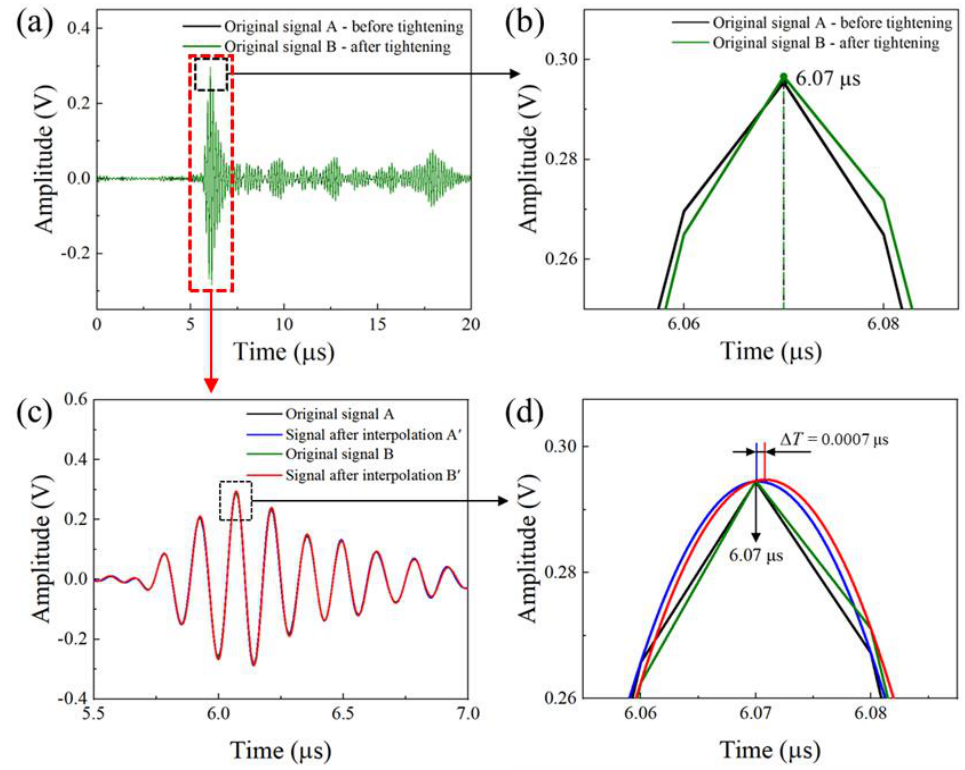
Figure 8. ( a ) Original signal before and after applying a small preload; ( b ) the waveform underwent a slight phase shift, but the data of the sampling points at the peak remained the same; ( c ) original sample data (temporal signals A, B) and interpolation waveforms (interpolated signals A’, B’) before and after loading; ( d ) rectangular window for comparing the TOF at the peak position between pre- and post − interpolation.